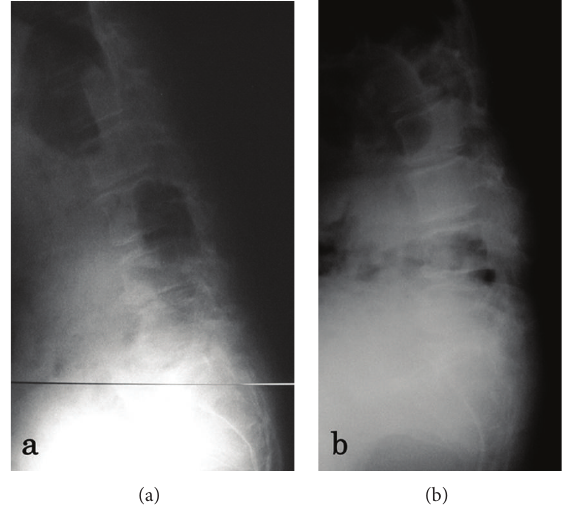
Figure 2: Lateral radiograph of the lumbar spine on lying (a) and standing (b). Kyphosis of the lumbar vertebrae increased on standing.